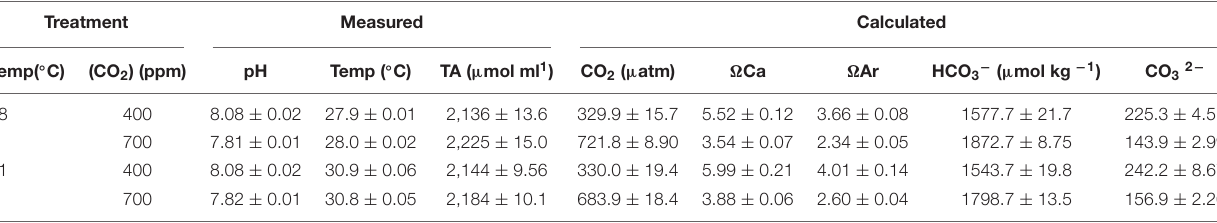
TABLE 1 | Seawater carbonate physio-chemical parameters during the experimental period. Treatment Measured